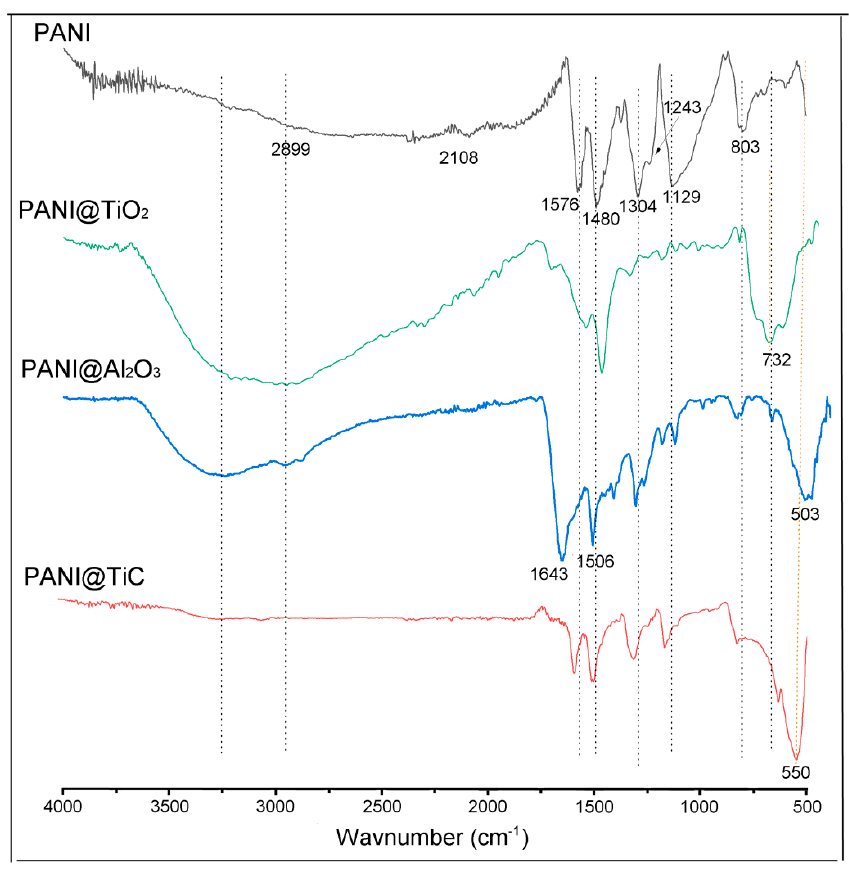
Figure 3. Fourier-transform infrared spectroscopy (FTIR) spectra of synthesized materials.